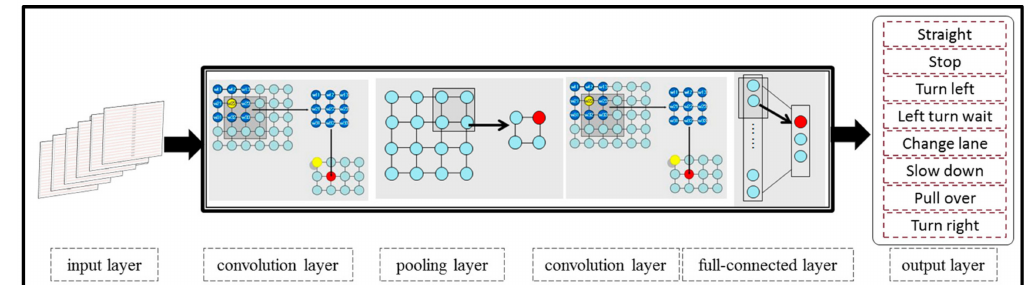
Figure 4. Spatiotemporal convolutional neural network algorithm pipeline.